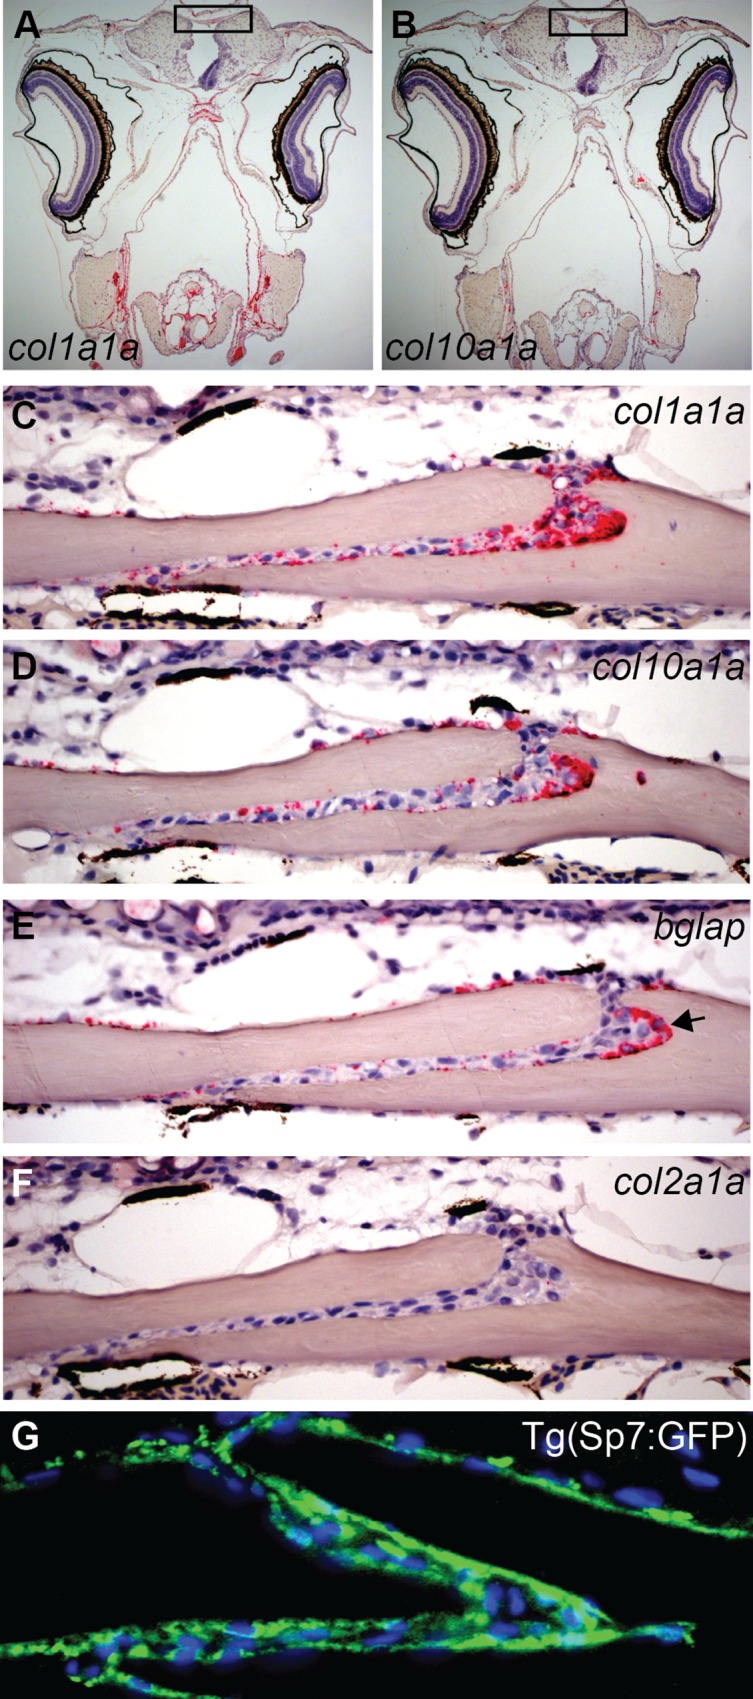
RNAscope in situ hybridization and IHC for GFP performed for adults at 12 wpf.(A-F) Sequential sections (4 μm) of interfrontal suture expression. Names of genes tested by RNAscope in situ hybridization are labeled on each image. (A, B) Representative images of the skull taken at low magnification (5x) that visualize entire expression pattern of (A) col1a1a and (B) col10a1a. (C-F) Images of interfrontal sutures and the expression of representative genes as labeled on each image. (G) Immunohistochemistry for sp7 observed in the interfrontal suture using a GFP reporter in the Tg(sp7:EGFP)b1212 transgenic line. Transverse paraffin section, GFP positive cells (green) and nuclei stained with DAPI (blue).